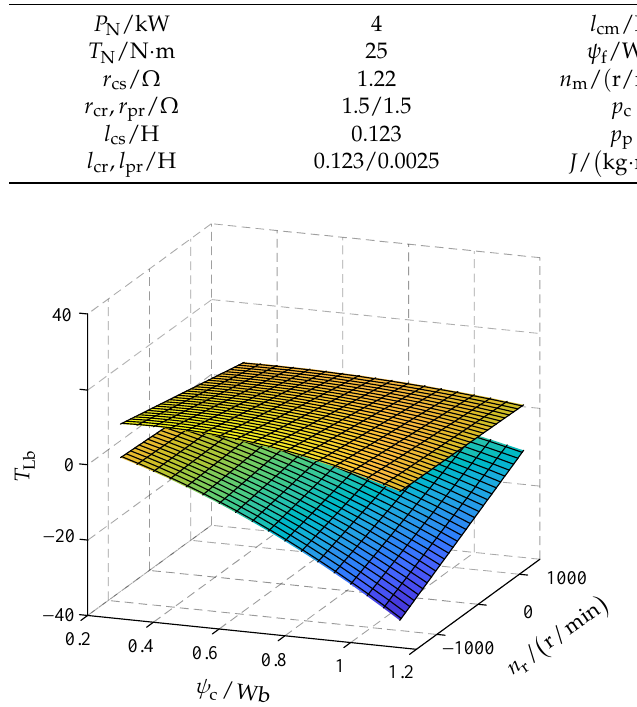
Figure 5. The upper and lower boundaries of load torque. Table 2. The upper and lower boundaries of load torque at speed of 1500r/min.